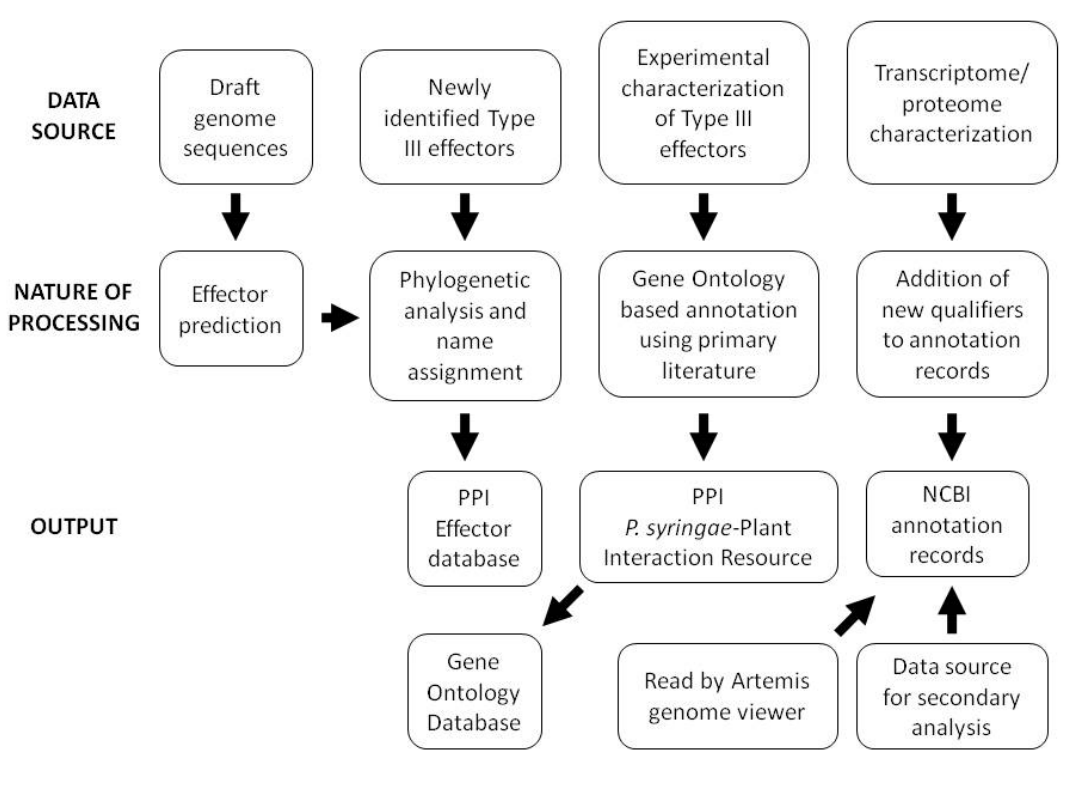
Figure 2. Strategy for data management used at the Pseudomonas-Plant Interaction (PPI) genome resources website